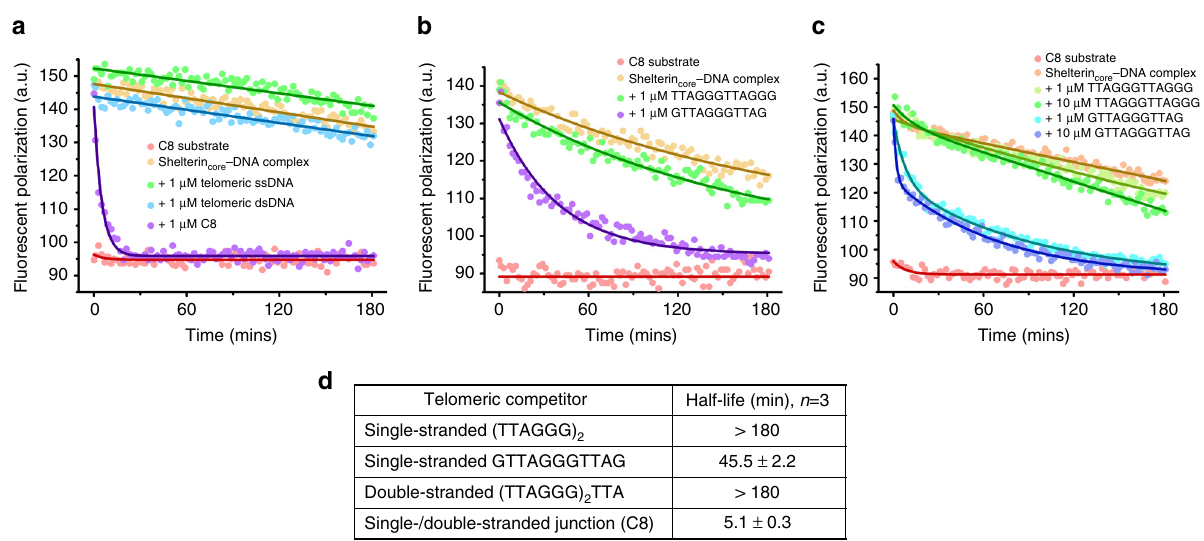
Fig. 3 Shelterin core complex bound at ss/ds telomeric junction remains stable in the presence of excess telomeric single-stranded or double-stranded DNA. a Fluorescence polarization assay to measure the dissociation rate of pre-formed shelterin core -Alexa488-C8 probe protein – DNA complex in the presence of excess single-stranded, double-stranded and ss/ds junction telomeric competitors. 5 nM of Alexa488-C8 probe was incubated with 100 nM of shelterin core complex for 30 min before adding 1 µ M competitor (200-fold excess to fl uorescent probe). b Comparison of the complex dissociation rate with single-stranded telomeric competitors with either 3 ′ TTAGGG or TTAG. c Comparison of dissociation rates of complexes with 1 and 10 µ M single- stranded telomeric DNA competitor. d Summary of complex dissociation rates in the presence of various telomeric competitors obtained from single- exponential decay function fi tting. (Error bars are s.d., n = 3 independent experiments using 2 different protein